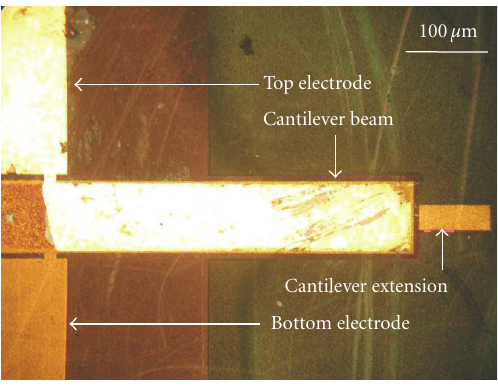
Figure 10: Fabricated piezoelectric ZnO cantilever.